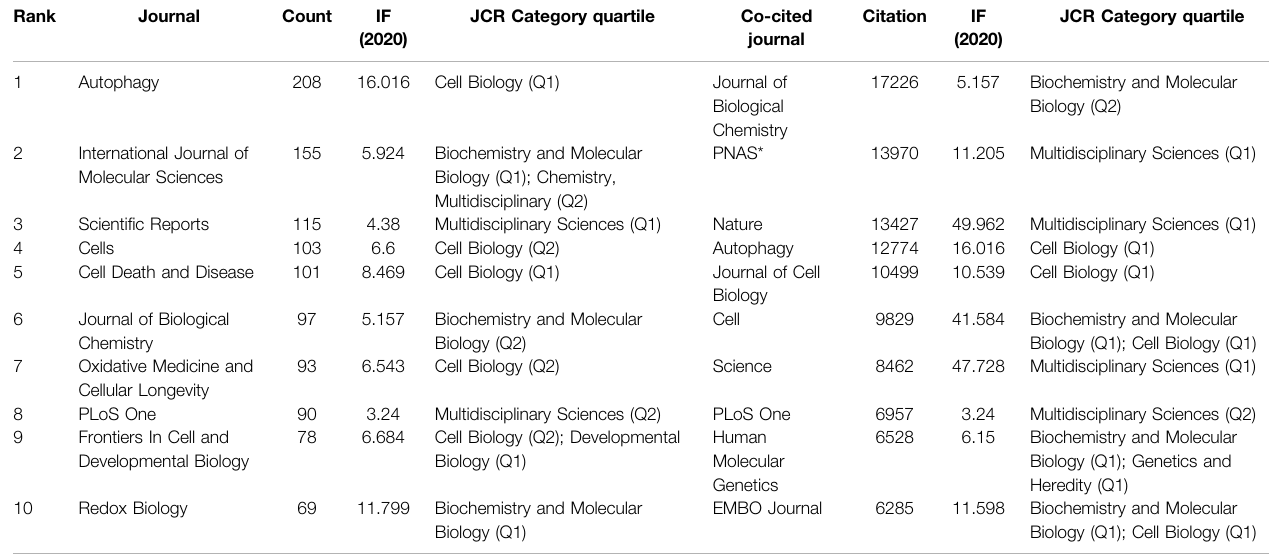
TABLE 3 | Top 10 journals and co-cited journals contributed to mitophagy